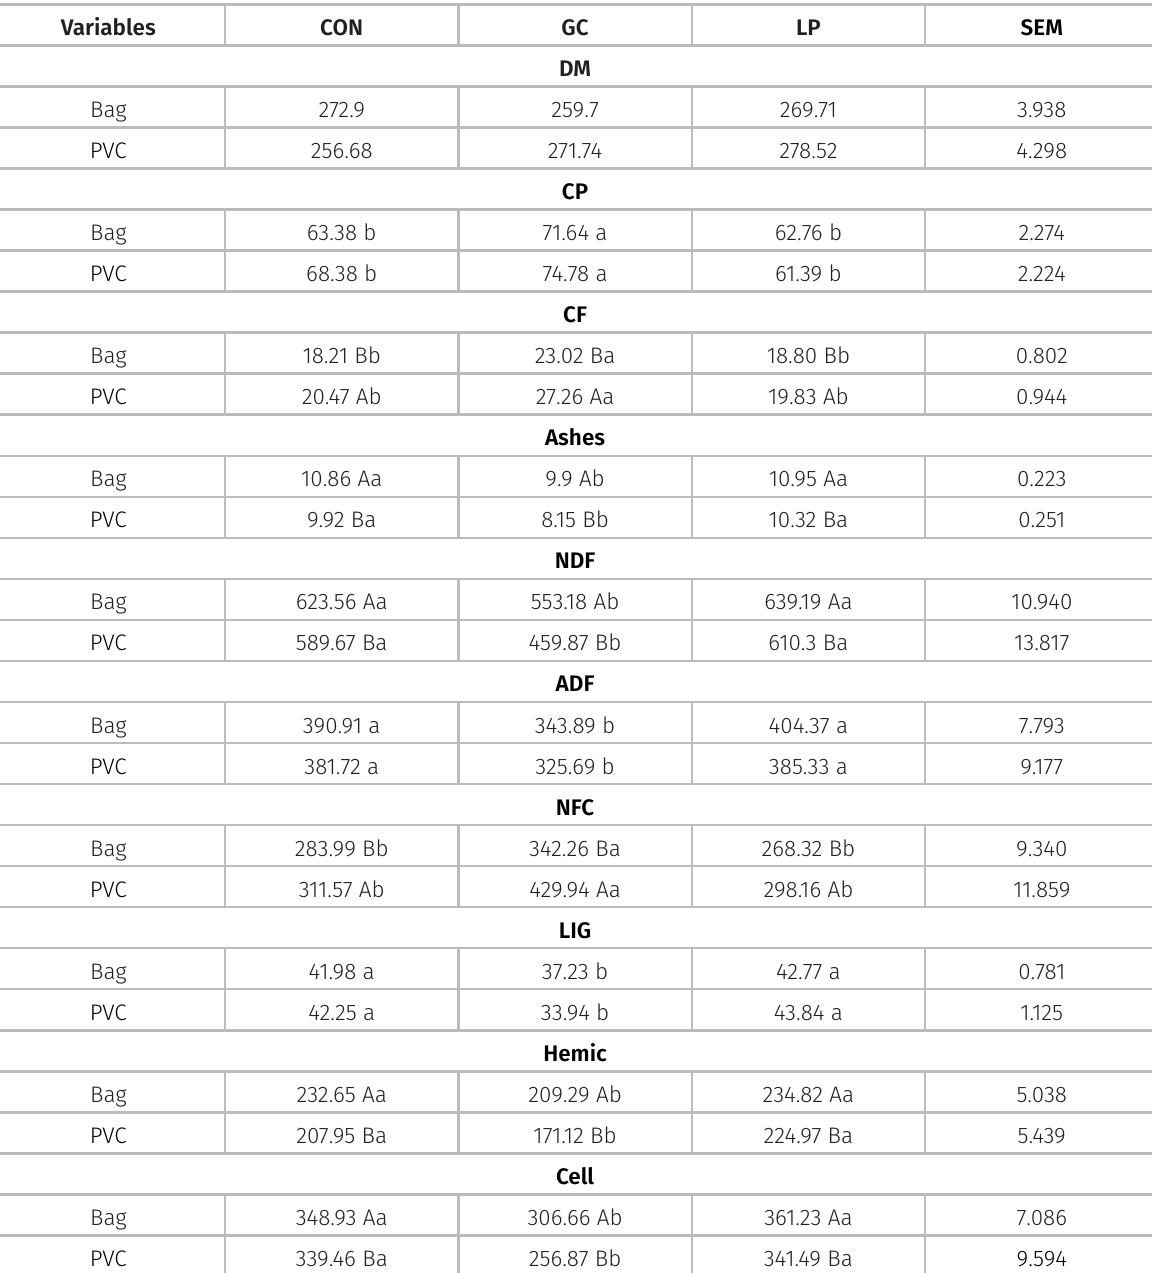
Table II. Effects of additives and silo type on the chemical composition of pearl millet silage.